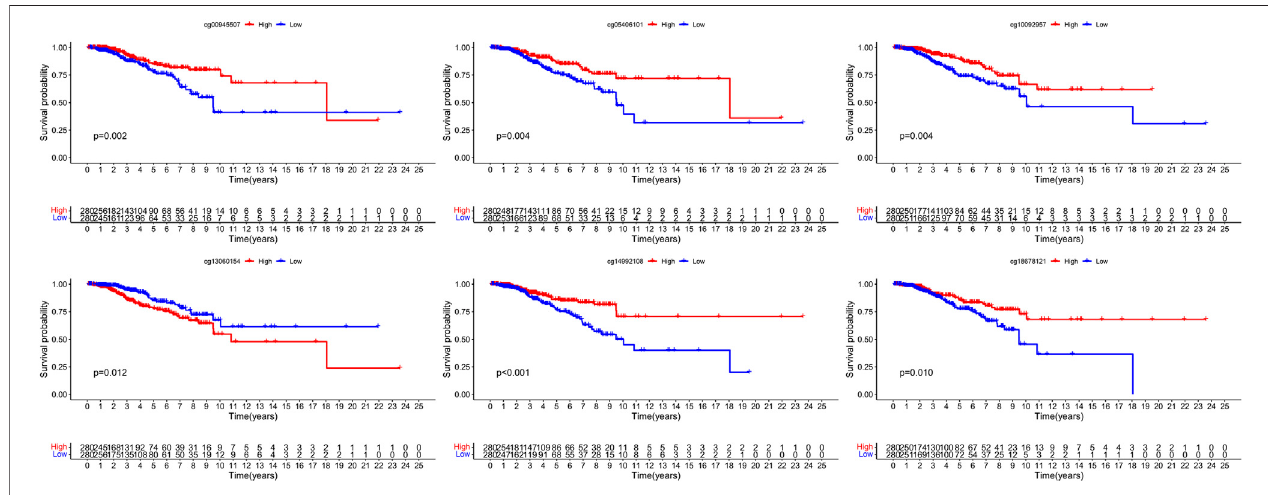
FIGURE 4 | The survival difference of hypermethylation and hypomethylation of the six signature CpG loci.